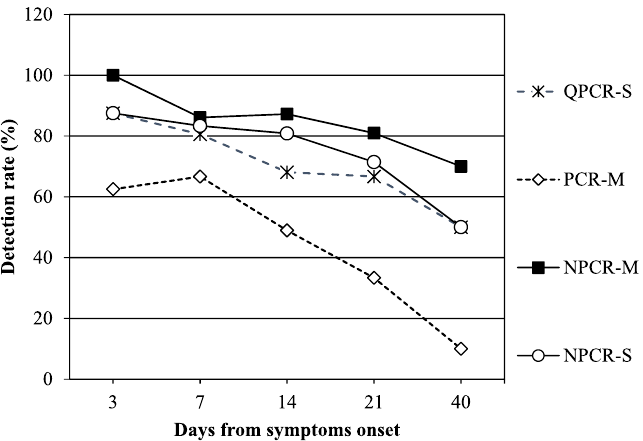
Figure 2. Time kinetic study of various PCR assays using severe fever with thrombocytopenia syndrome (SFTS) patient samples after symptom onset day. Single-round PCR-M = reverse transcription (RT) polymerase chain reaction (PCR) targeting the M segment of the SFTS virus. NPCR-M = RT-nested PCR targeting the M-segment of the SFTS virus. NPCR-S = RT-nested PCR targeting the S-segment of the SFTS